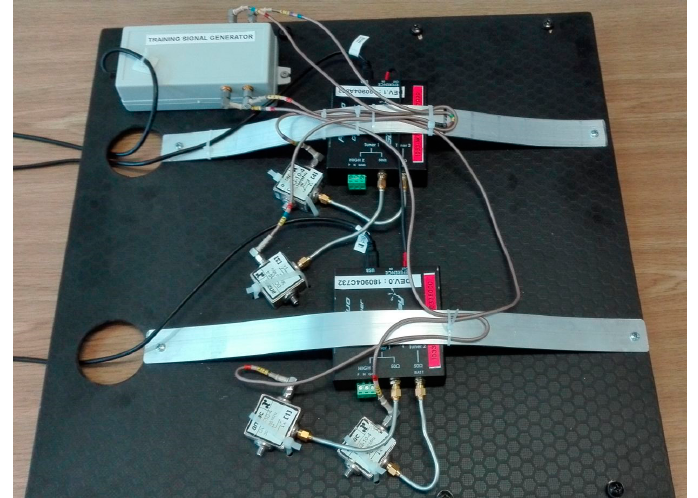
Figure 6. Four-channel receiver with the training signal generator and the directional couplers.